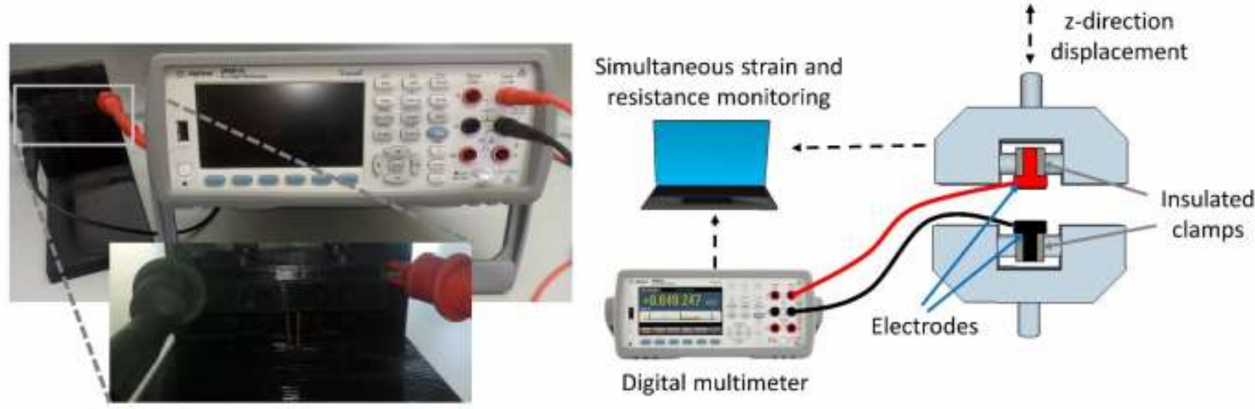
Figure 1. Equipment used to measure the superficial electrical resistance ( left ) and representation of the setup to evaluate the piezoresistivity of the samples ( right